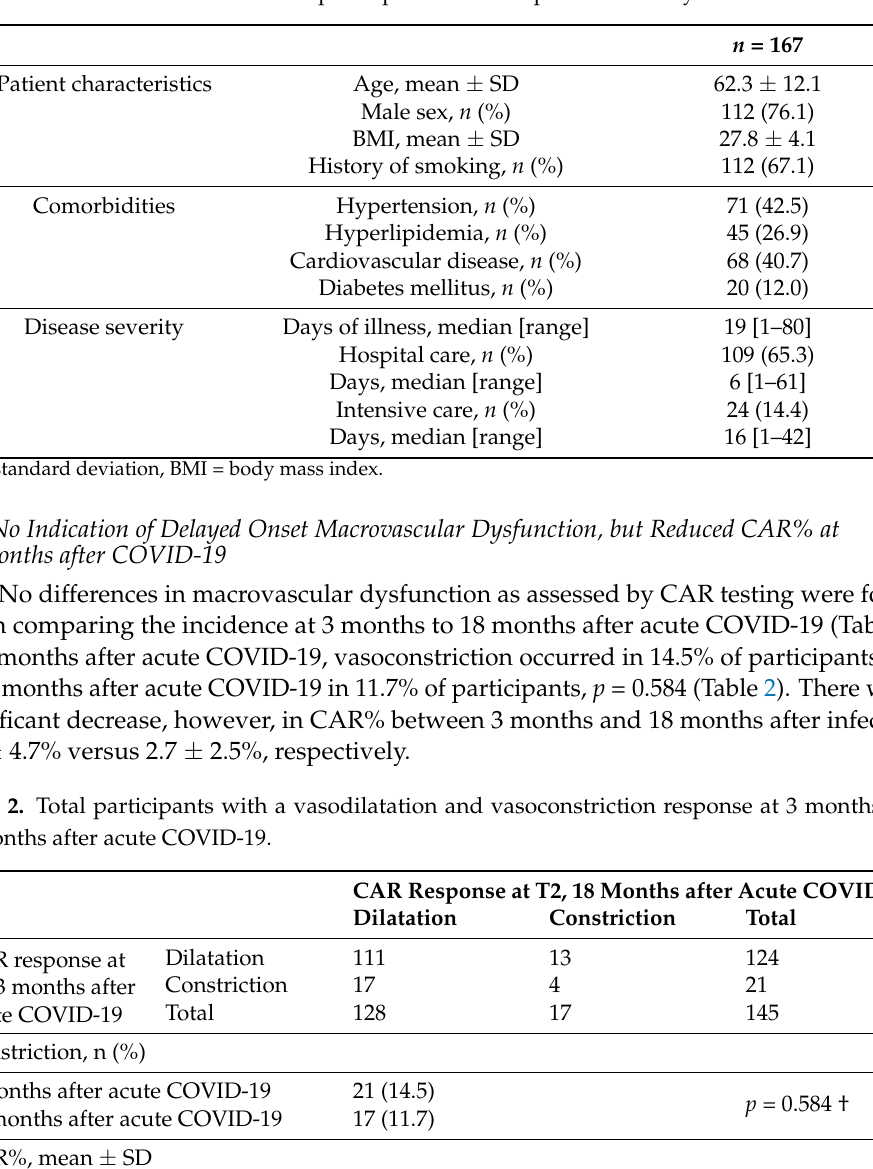
Figure 1. Flowchart of the study population. T1: 3 months after acute COVID-19. Table 1. Baseline characteristics of all participants who completed the study.